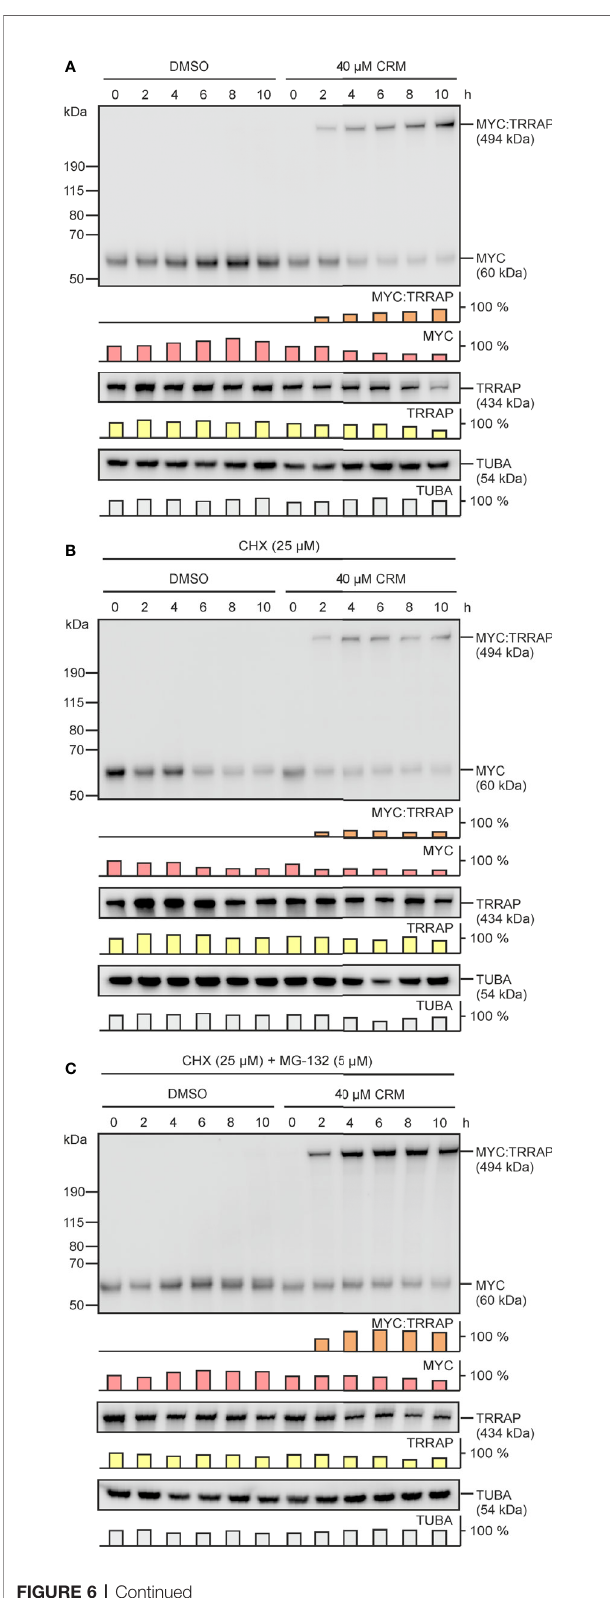
FIGURE 6 | Curcumin does not reduce the stabilities of the MYC and TRRAP proteins. (A) Equal numbers (2.5 × 10 5 ) of HEK293T cells were seeded onto MP24 wells and incubated with increasing concentrations of curcumin or the solvent dimethyl sulfoxide (DMSO), and protein extracts